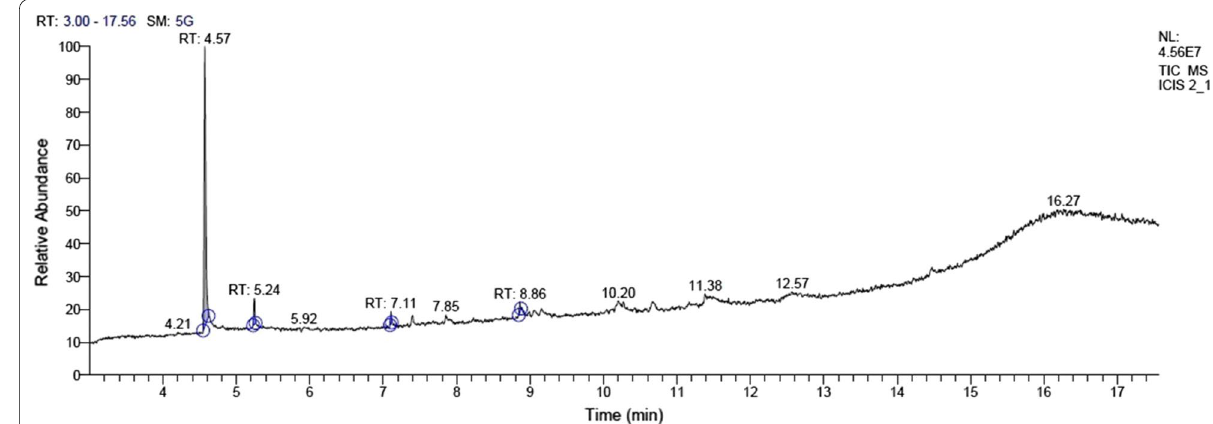
Fig. 2 GC–MS spectrum of ethanolic extract of L. rugosa